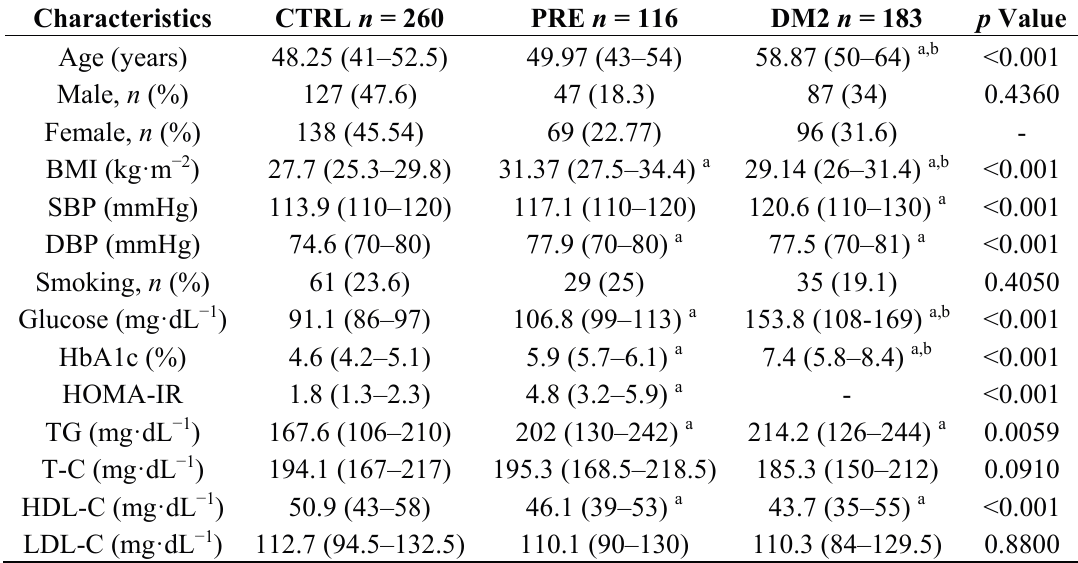
Table 1. Clinical and anthropometrical characteristics of control (CTRL), prediabetic (PRE) and diabetes mellitus (DM2) individuals. Data are presented as mean (interquartile range). Statistical significance p < 0.05: a vs. CTRL and b vs. PRE with a Wilcoxon rank-sum